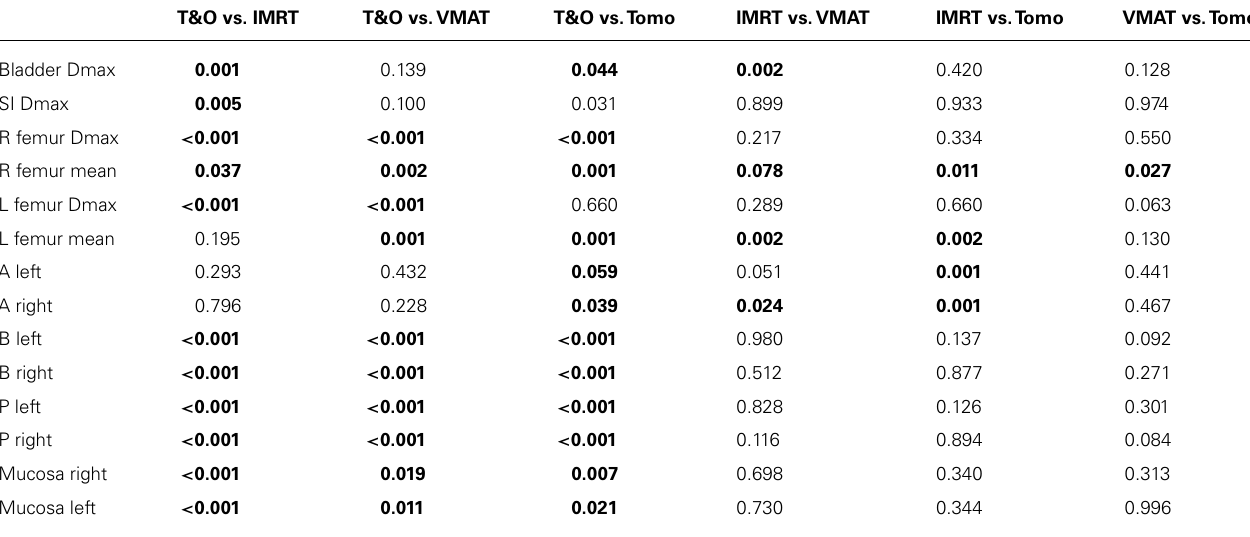
Table 3 | Results of two-tailed t -tests for pair-wise comparisons of tandem and ovoid, intensity-modulated radiotherapy, volumetric modulated arc therapy, andTomoTherapy techniques for dosimetric parameters and doses to brachytherapy points that showed statistically significant differences onANOVA analysis of normalized